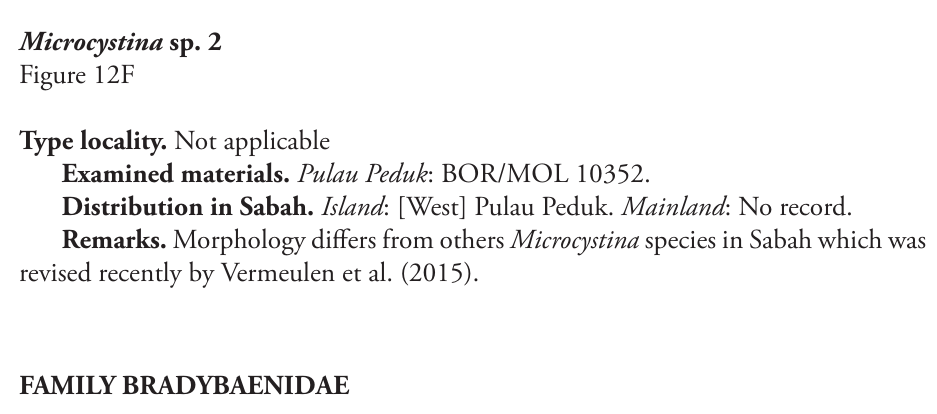
Type locality. Not applicable.